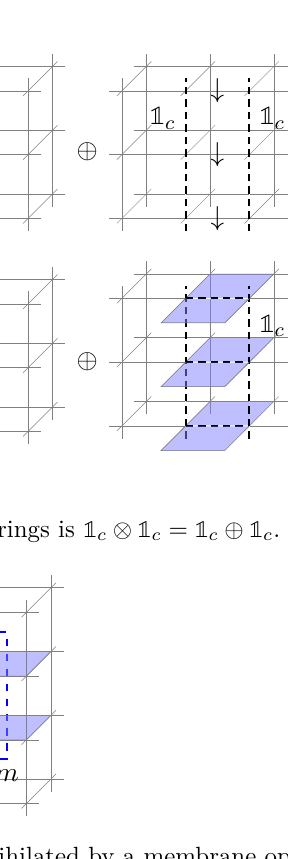
Figure 16. An m -loop can be created/annihilated by a membrane